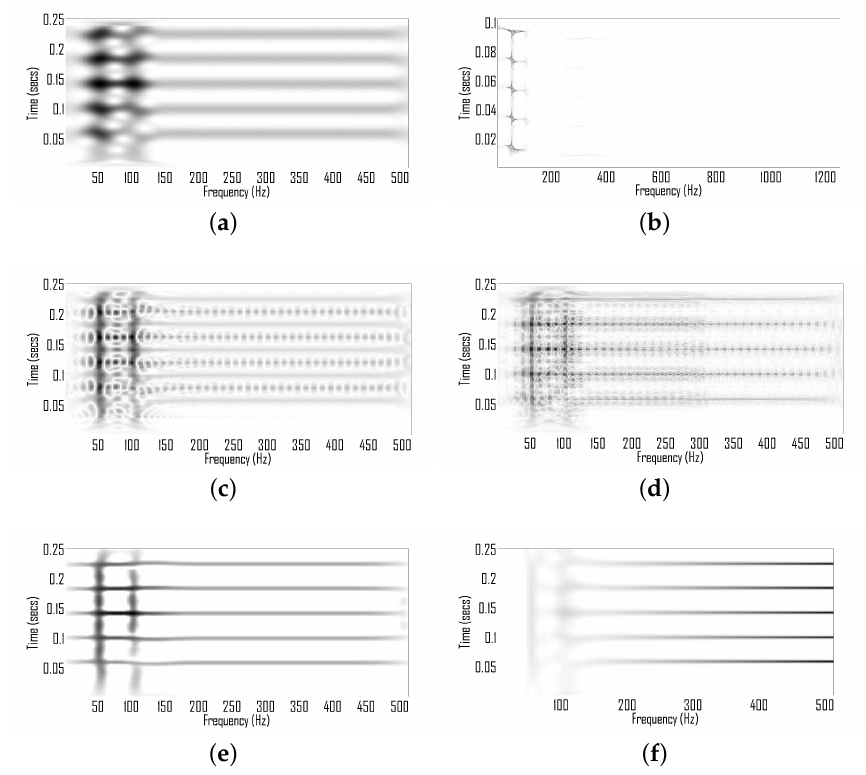
Figure 5. Time-frequency plots of the synthetic signal, given by (18), ( a ) Spectrogram (hamming window of length 45); ( b ) reassigned Spectrogram; ( c ) MBD ( β = 0.1 and lag window of length 64); ( d ) Gabor Wigner transform (Gabor transform of window length 45 is used); ( e ) the adaptive TFD ( a = 3 and b = 8); and ( f ) the